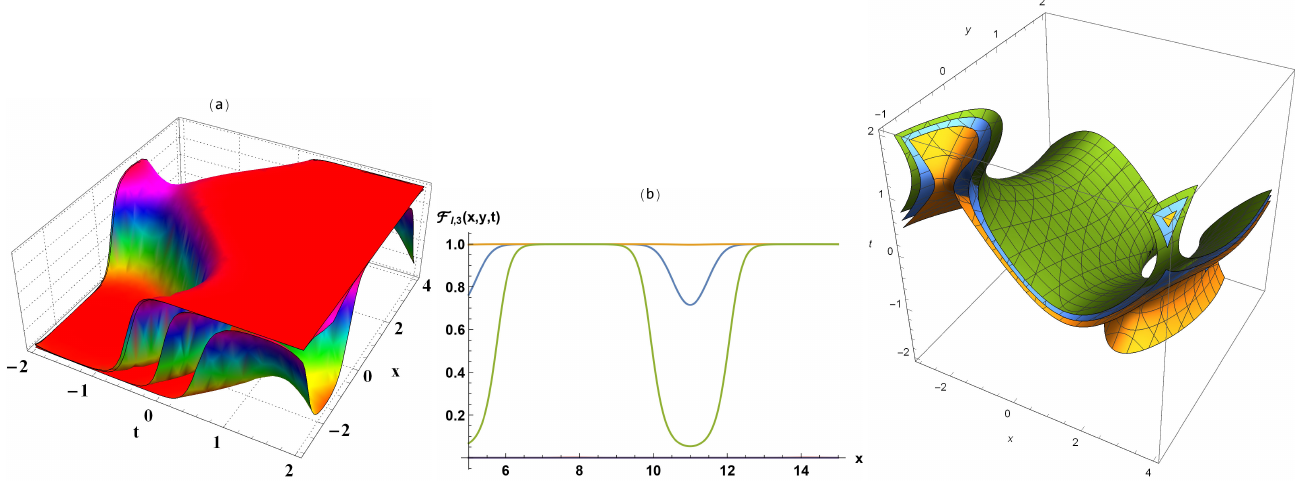
Figure 1. Computation wave solutions of Equation (12) in 3D ( a ), 2D ( b ), and contour ( c )